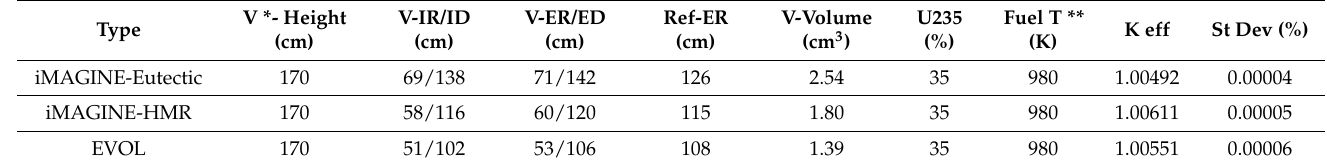
Table 9. Comparison of the critical dimension between three salt fuel